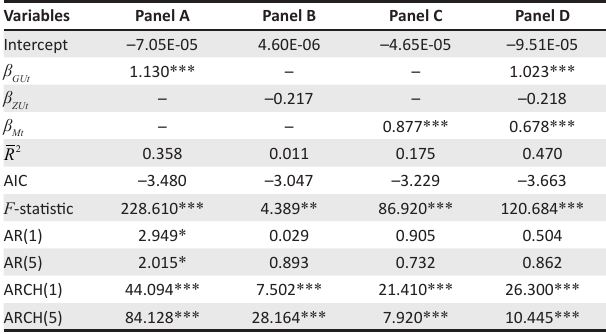
TABLE 4: Least squares model